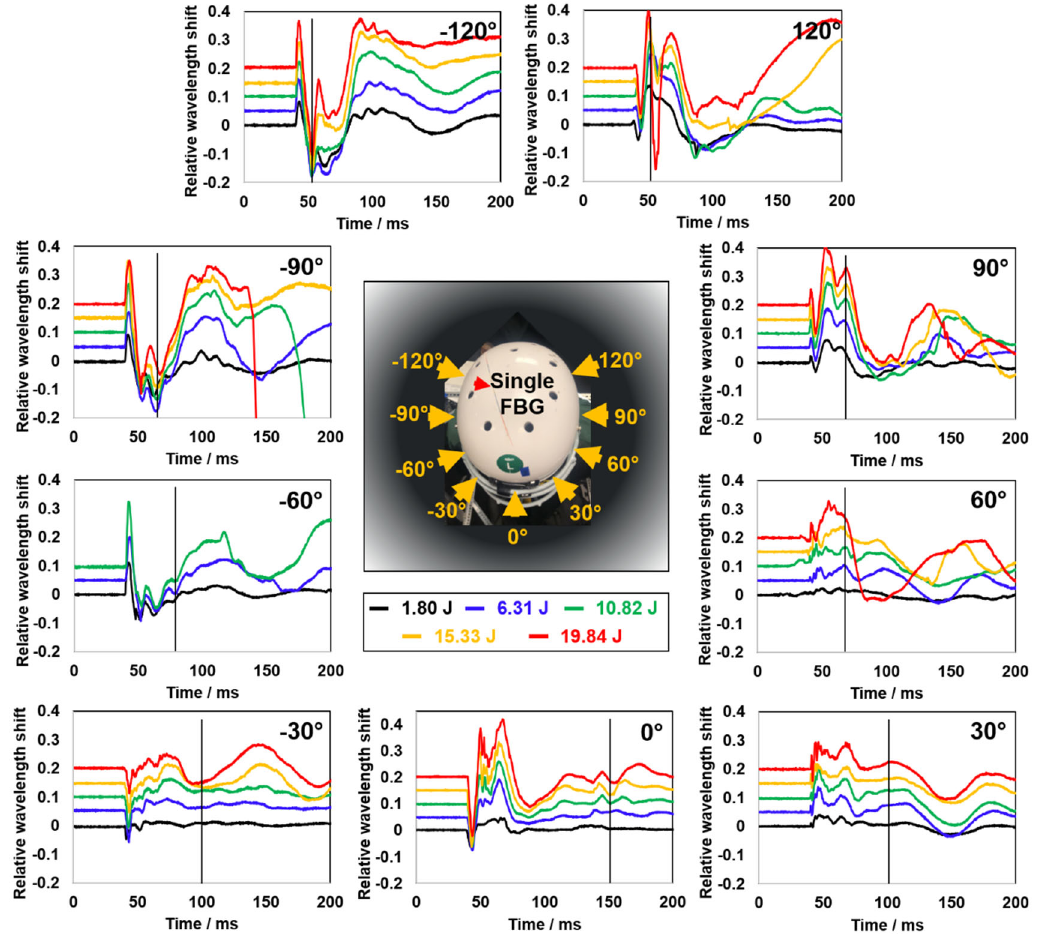
Figure 8. First 200 ms of the transient oscillatory signals resulting from pendulum impacts on the wireless smart helmet using nine different directions ( − 120 ◦ , − 90 ◦ , − 60 ◦ , − 30 ◦ , 0 ◦ , 30 ◦ , 60 ◦ , 90 ◦ , and 120 ◦ ) and five different kinetic energy levels (1.80 J, 6.31 J, 10.82 J, 15.33 J and 19.84 J). All corresponding transients were synchronized. The black line in each plot indicates the estimated time point from which the regularity of the signal started to dissipate. Yellow arrows and labels in the central photograph indicate the applied impact directions.